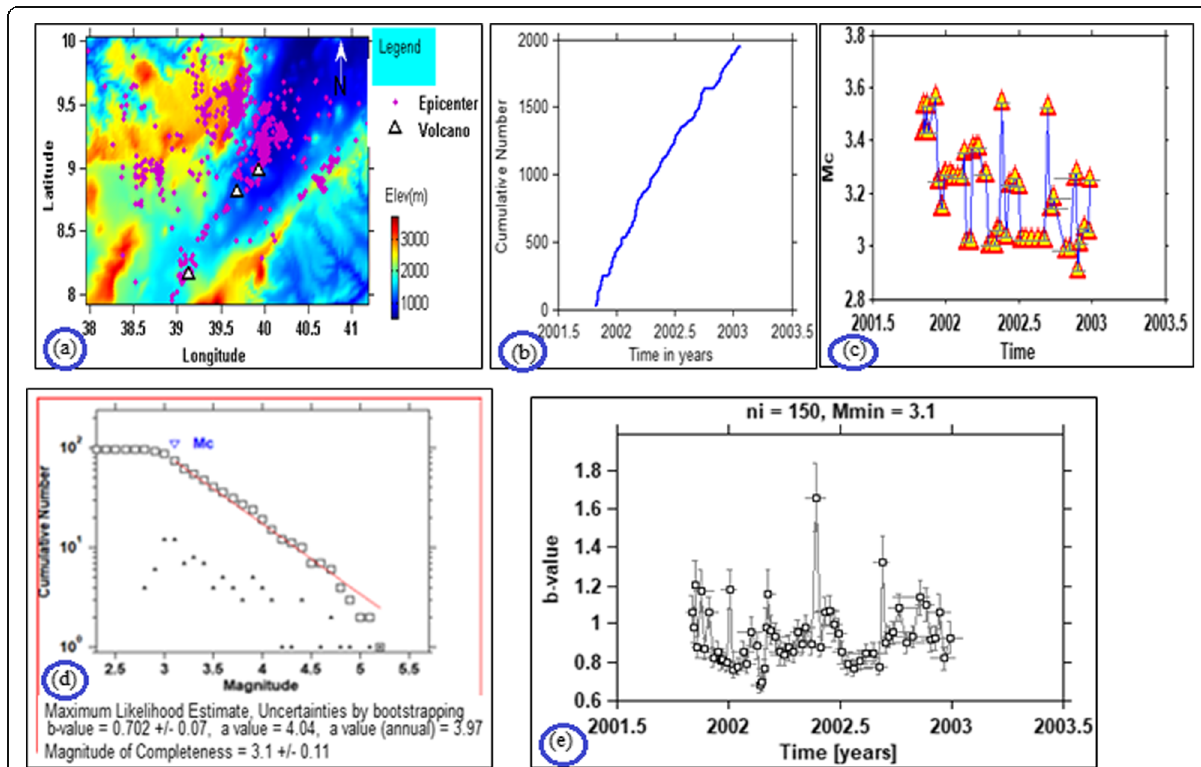
Fig. 10 Northern Main Ethiopian Rift (NMER): ( a ) Seismicity map of NMER ( b ) Cumulative number of events vs time-straight-line trend -relatively complete ( c ) Magnitude of Completeness (Mc) with time ( d ) the average value of Seismicity parameters (a, b, and Mc) of the region ( e ) Temporal variation of b-value with period of completeness, ni = 150, Mmin =